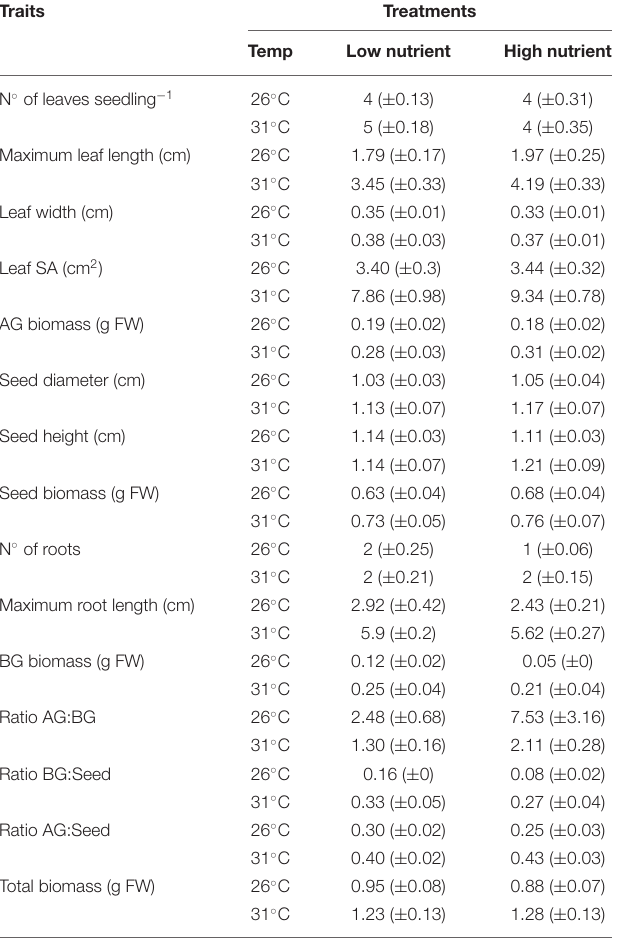
TABLE 2 | Morphological traits (mean ± SE, n = 6) of Enhalus acoroides seedlings in the four different temperature (Temp) and nutrient treatments at the end of the experiment.